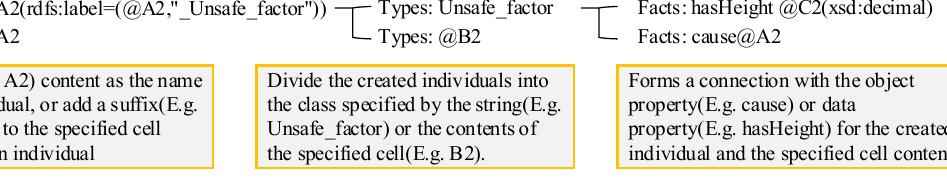
Table 1. Knowledge types of a building safety design